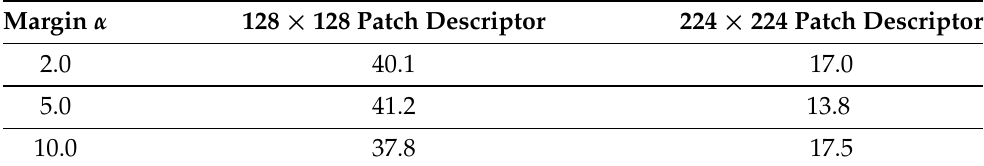
Table 1. FPR95 rates observed for learned